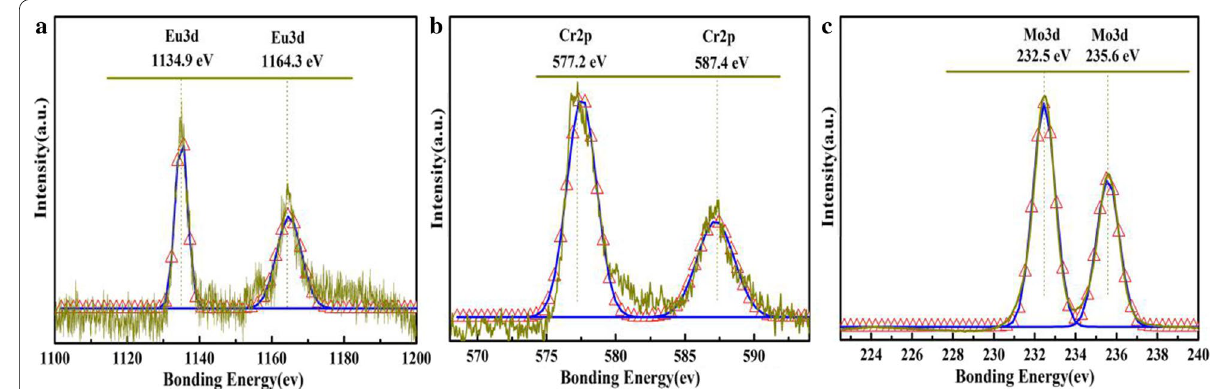
Fig. 11 XPS spectra of EuCrMo 6 : a Eu3 d ; b Cr2 p ; c Mo3 d (dark yellow line: experimental data; red scatter: fitting curve; blue line: spin–orbit partner